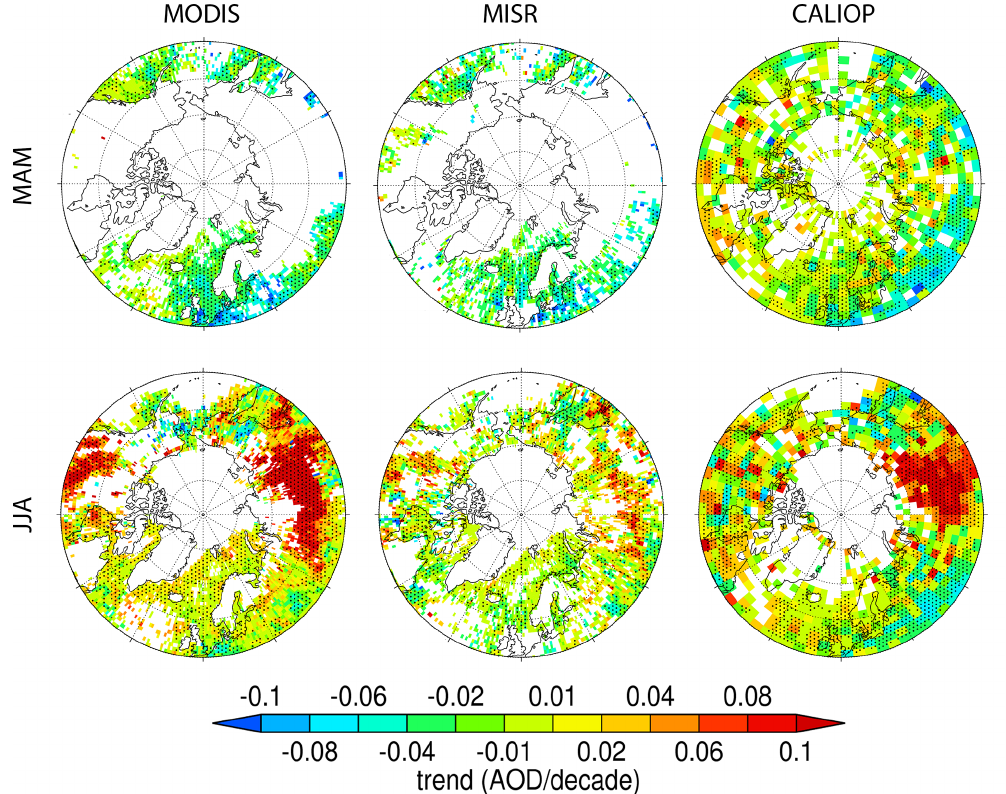
Figure 9. MODIS, MISR, and CALIOP MAM and JJA AOD trends for the time periods and AOD wavelengths given in the caption for Fig. 3. Trends in the dotted areas are statistically